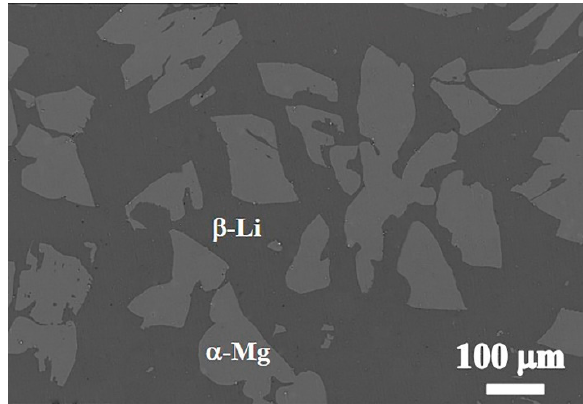
Figure 1. SEM microstructure of the Mg-9Li alloy.